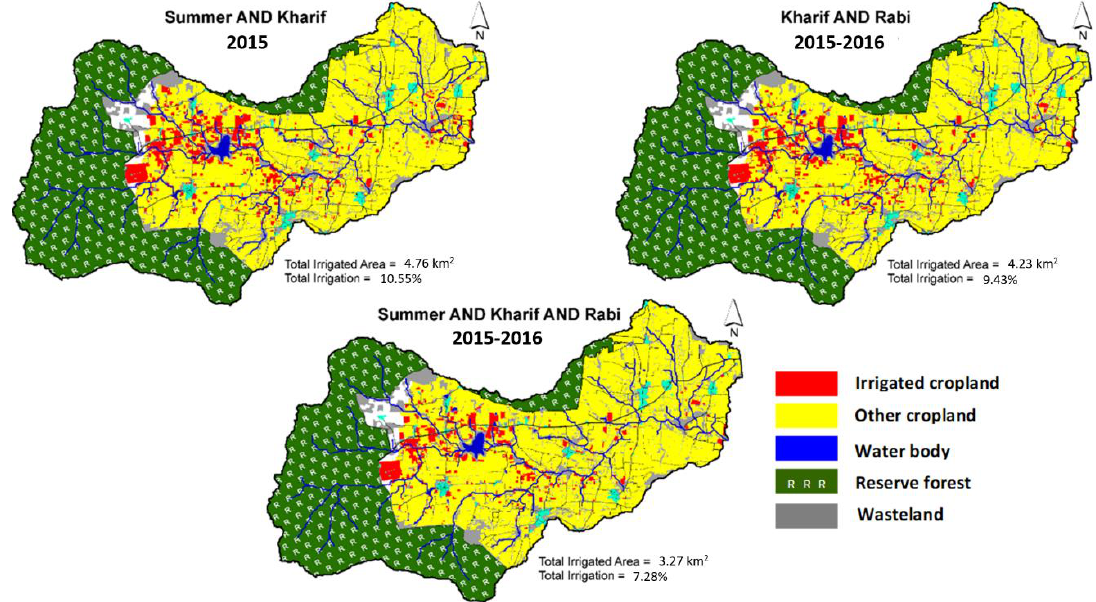
Figure 11. Classification of two-season (summer and kharif; kharif and rabi) and annually irrigated (summer and kharif and rabi) cropland classification for 2015–2016.